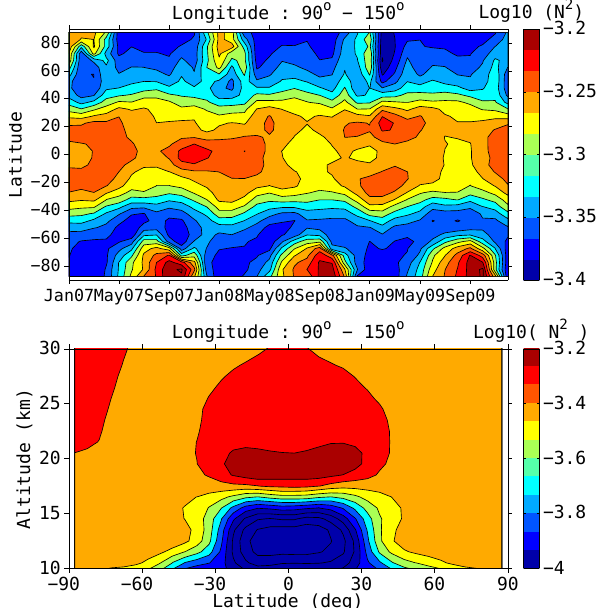
Figure 4. Top panel: latitude–time variation in Brunt–Väisälä fre- quency squared, N 2 in rads − 2 averaged in the 20–27km height range. The N 2 values are averaged every 5 ◦ in latitude. Bottom panel: altitude–latitude variations in N 2 for a 3-year average.